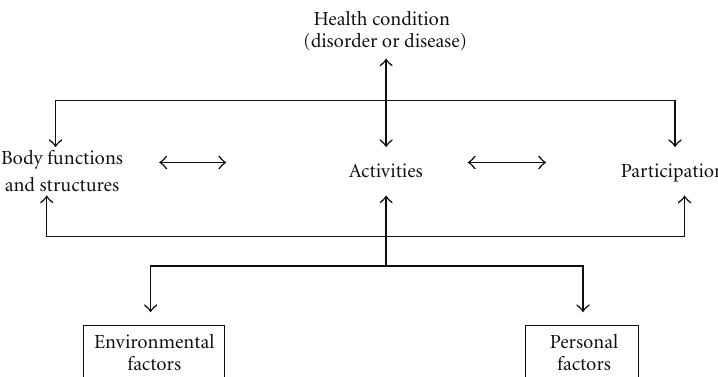
Figure 1: Components of international classification of functioning disability and health. (Printed with permission: WHO-ICF